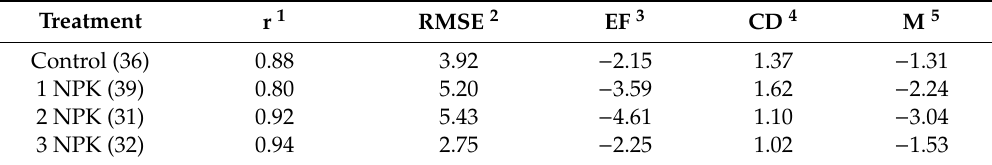
Table 2. Statistical evaluation of the results of modelling the dynamics of organic carbon reserves using the Roth-C model in the long-term experiment of